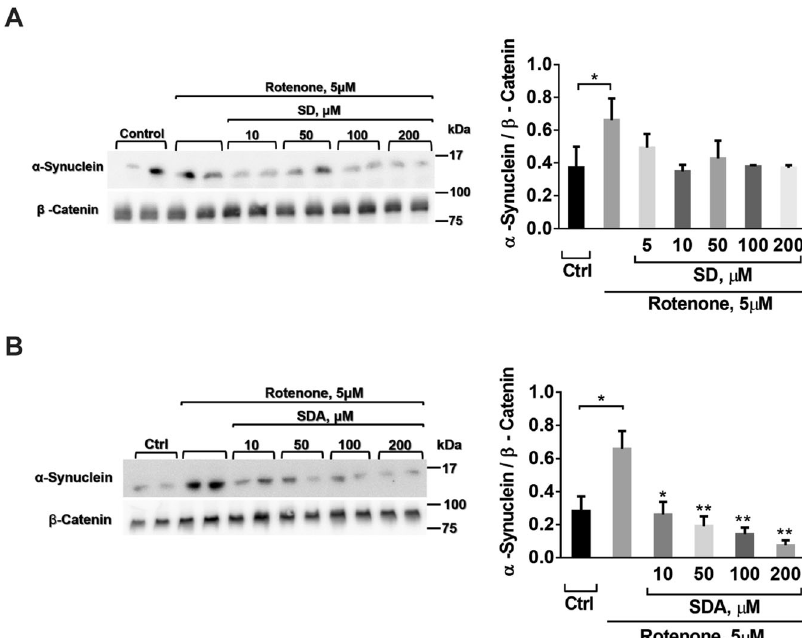
Fig. 7 SD and SDA lower rotenone-induced α -synuclein level in SH-SY5Y cells. SH-SY5Y cells were treated with A SD or B SDA at the concentrations as indicated, for 60 min. Then the cells were washed and incubated with 5 µM rotenone for 16 h. Equal amounts of proteins of cell lysates were loaded and separated on 12% SDS-PAGE. The level of α -syn in the cell lysates was determined using α -synuclein antibodies. The blots were cut prior to hybridization with the corresponding antibodies, shown in Fig. S12. The values calculated by densitometry shown ( right ) are averages (±SEM) of two independent experiments normalized with housekeeping level of β -catenin; Student ’ s t-test (two populations) was performed for rotenone treated cells. * P value < 0.05; ** P value <